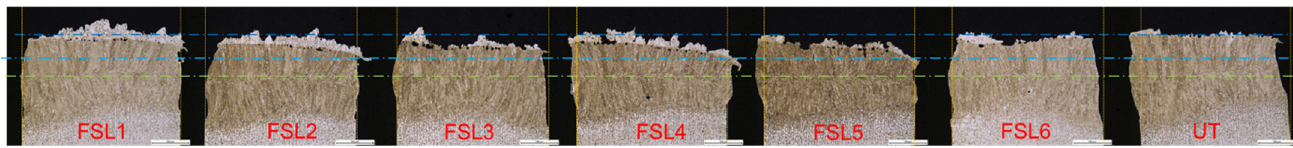
Figure 13. Fracture images from the end of the seam. Table 7. Summary of the microscopy examination results.